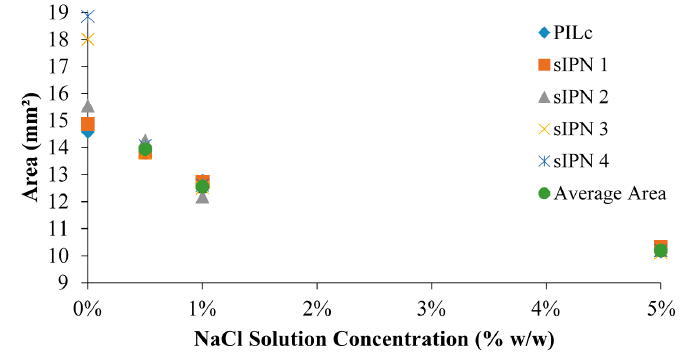
Figure 9. Area of the hydrogels in DI water and NaCl solutions of different concentrations: 0.5%, 1% and 5%, respectively, in the absence of light.